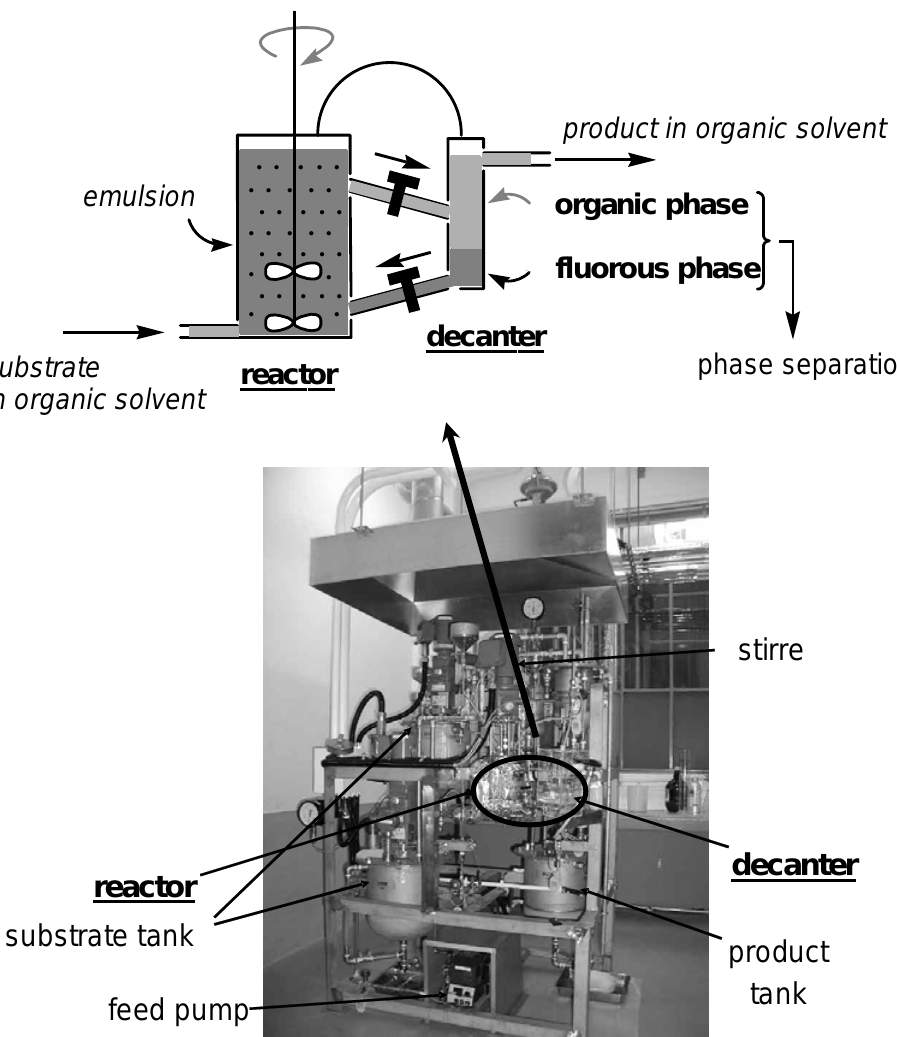
Figure 2. Bench-scale continuous-flow reaction system.